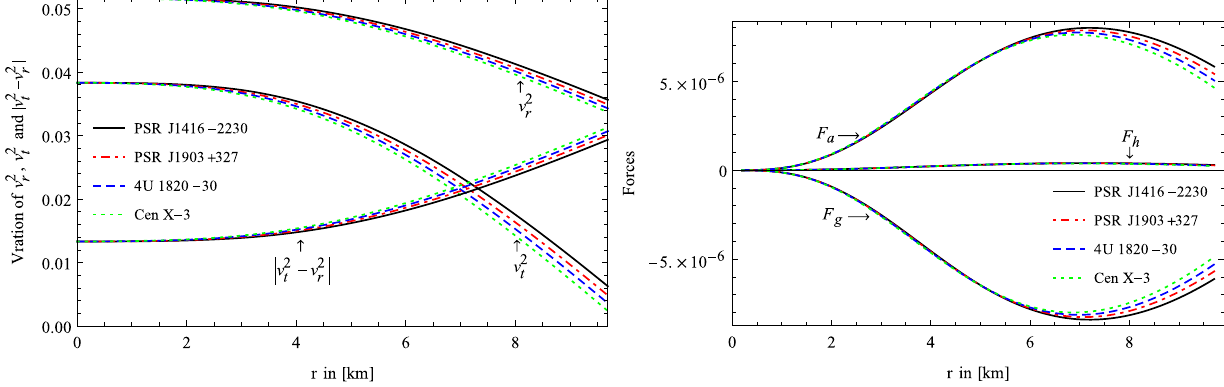
For plotting these graphs, the numerical values for the constant param- eters are α = 0 . 030390 / km 2 , β = 0 . 000075 / km 4 , C = 0 . 9985 and D = 0 .